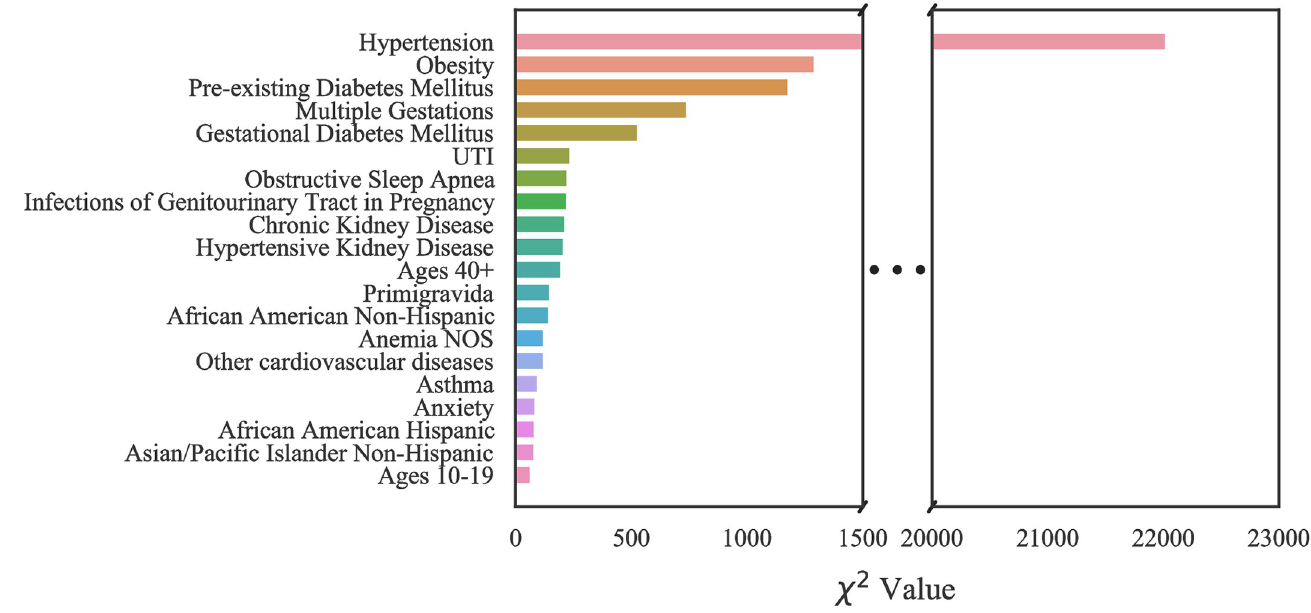
Fig 10. Feature ranking for the Full Texas